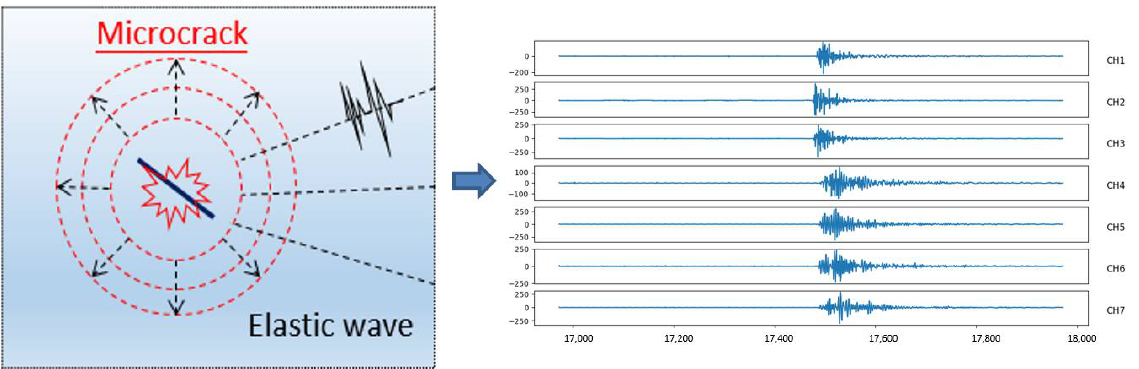
Figure 1. Schematic diagram of microseismic positioning principle.